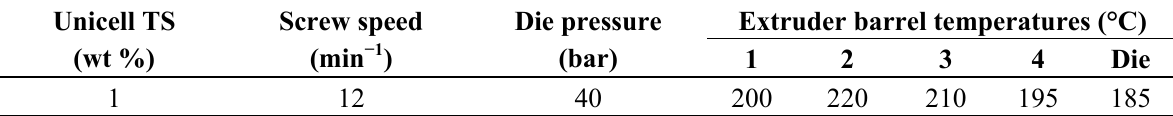
Table 3. Processing parameters for the foam extrusion tests of externally plasticized CA.